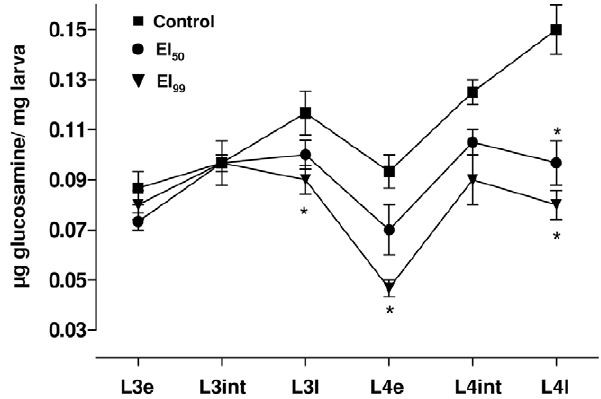
Figure 4. Effect of different novaluron concentrations on chitin production profile over Ae.aegypti L3 and L4 instars. Experi- mental time points are indicated horizontally. Symbols refer to the average value and standard deviation of three independent experi- ments. Asterisks indicate significant differences when compared to the control condition at the same experimental time point (ANOVA, P , 0.05). Each sample was collected on time points defined for the physiological instar development of the control group, according to Figure 3 (see section 4 of Methods).